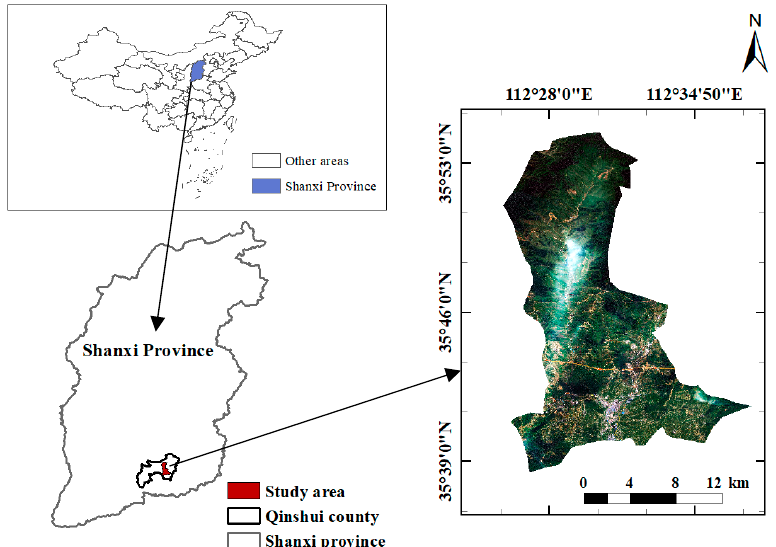
Figure 1. Geographic location of the study area and regional remote-sensing